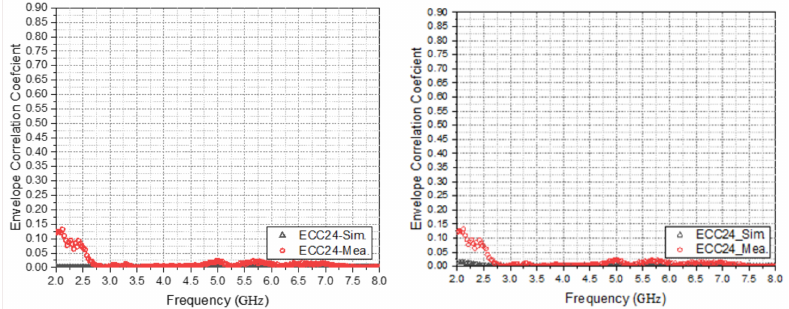
Figure 24. Comparison of ECC simulation and measurement between Ant. 3 and Ant. 4.